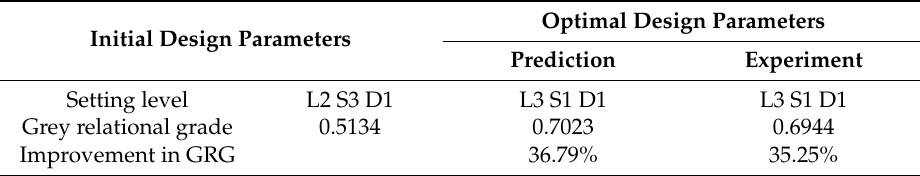
Table 12. Results of the confirmation experiment.